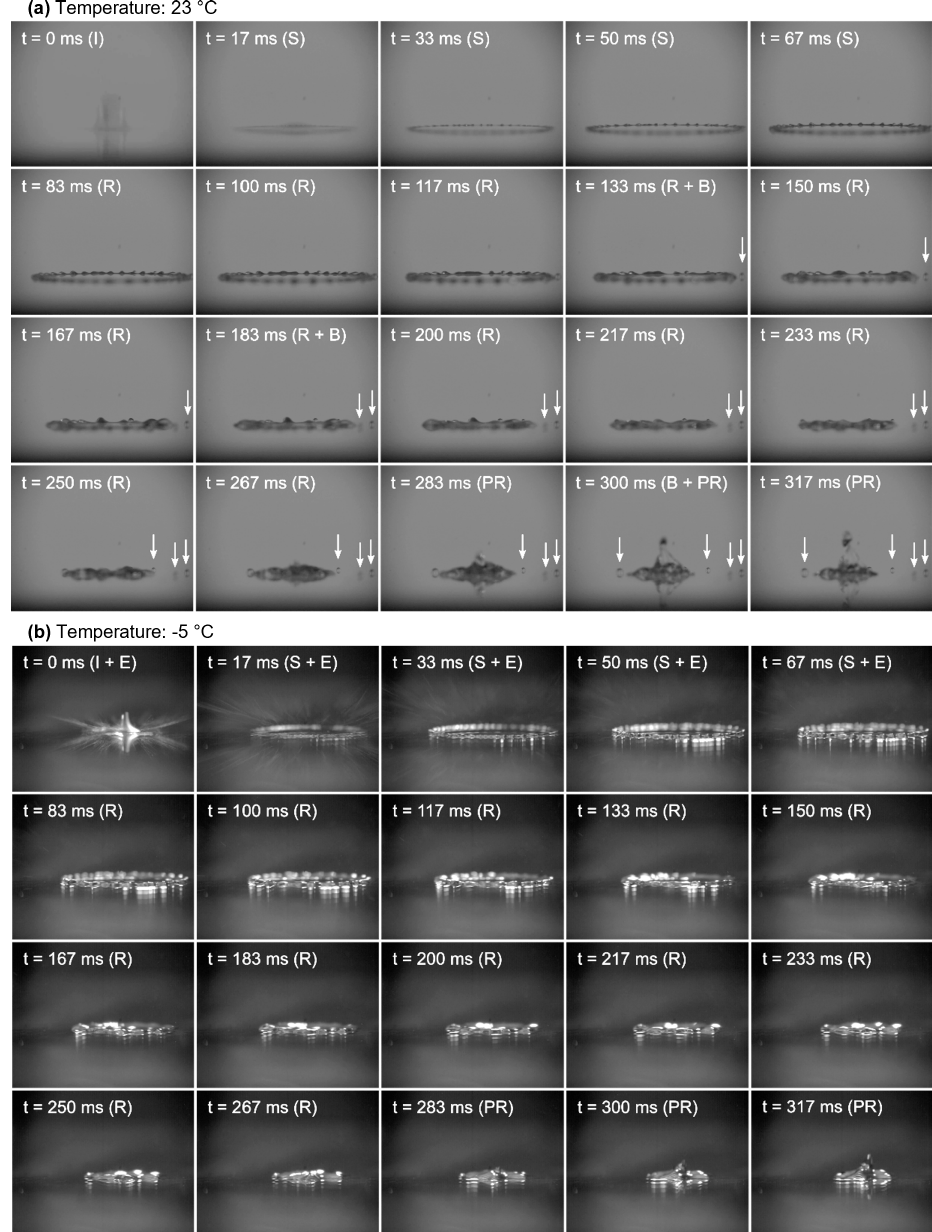
Figure 3. Frames from the high-speed camera configuration of a water drop impact on a glass slide when both the water drop and glass slide are at (a) room temperature (23 ◦ C) and (b) − 5 ◦ C. The impact phase (I), spreading phase (S), secondary drop formation/ejection during the spreading phase (E), retraction phase (R), secondary drop formation due to the receding break-up (B) and partial rebound (PR) of the water drop are indicated in the frames. Arrows indicate secondary drop formation during the retraction phase of the water